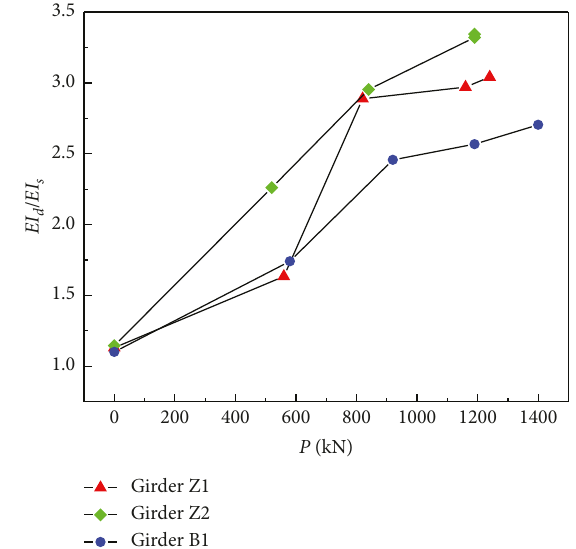
Figure 15: Ratio of dynamic stiffness to equivalent flexural